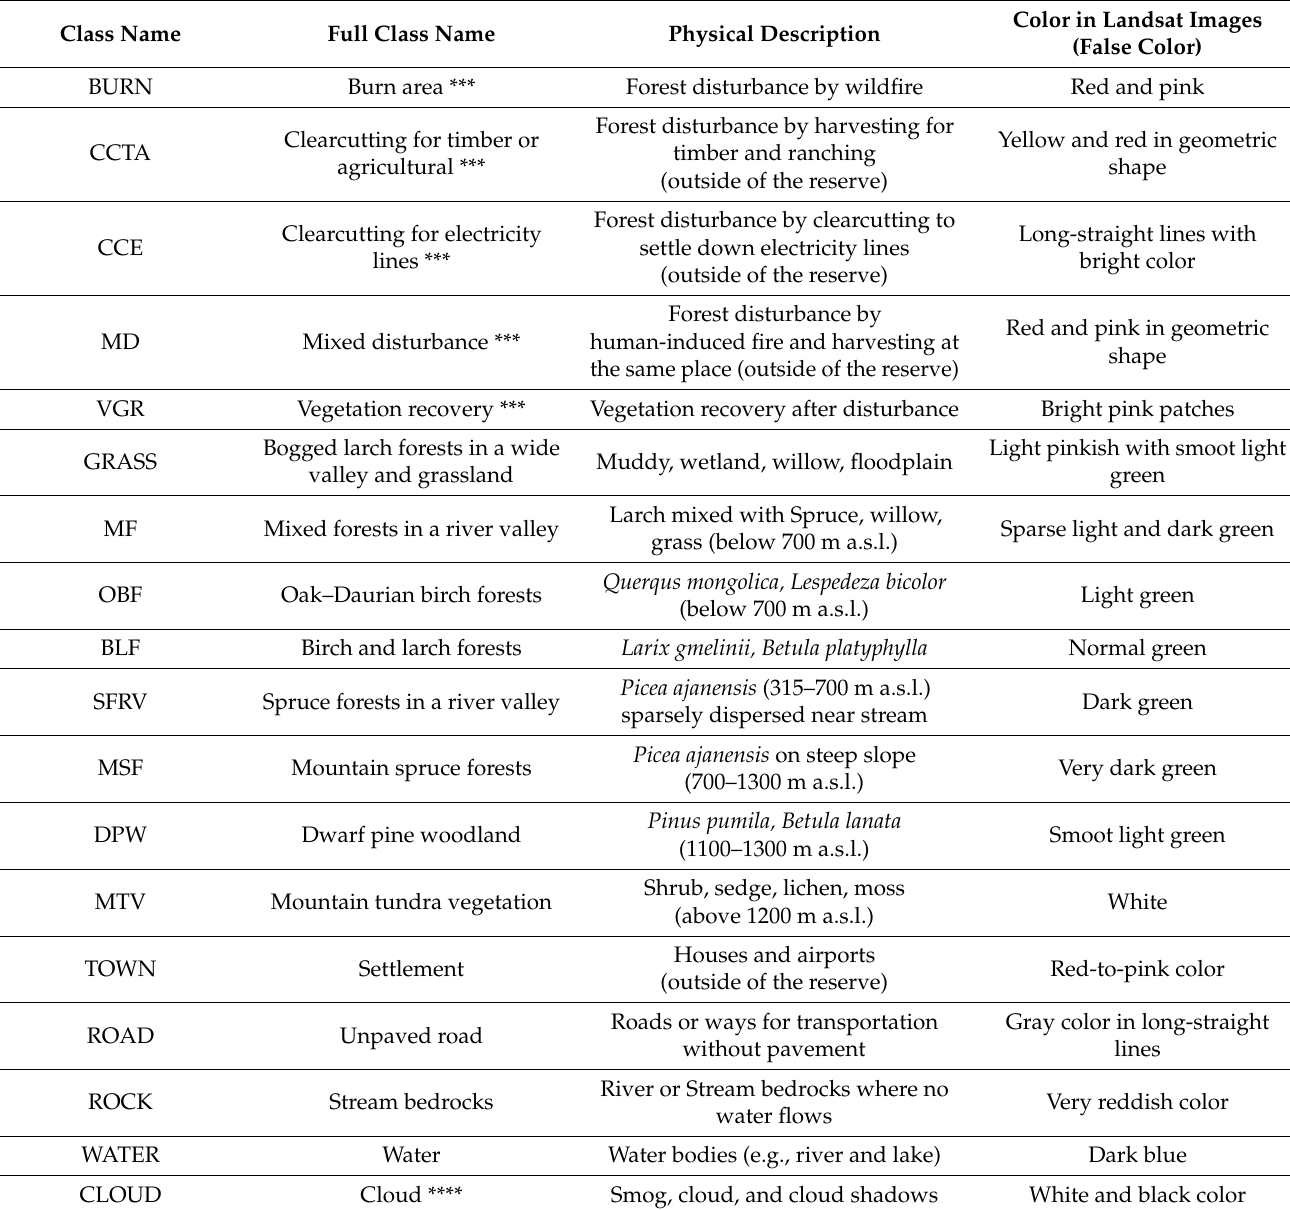
Table 2. Classification criteria for object-based segmentation classification (see also Supplementary Materials Figure